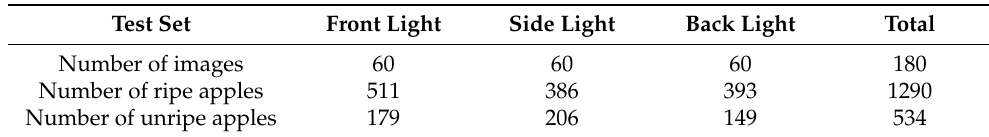
Table 1. Details of the test set